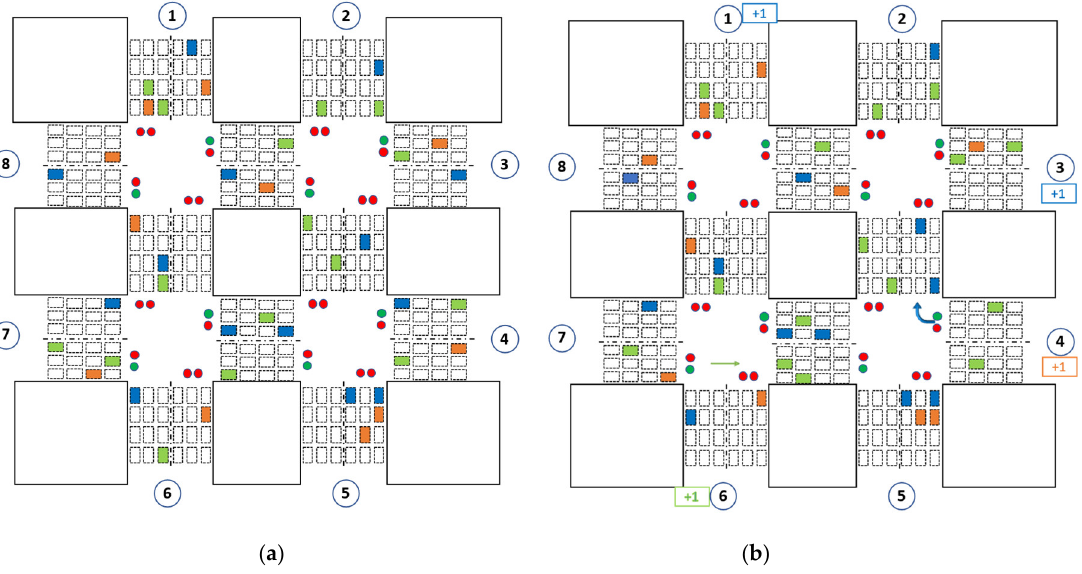
Figure 5. The traffic state of the road network, also called a city, ( a ) Traffic network state at time  and ( b ) Traffic network state at time  + 1 . As seen, four vehicles have left the city at the destinations labeled as 1, 3, 4, and 6. Thus, throughput is four between  and  + 1 .